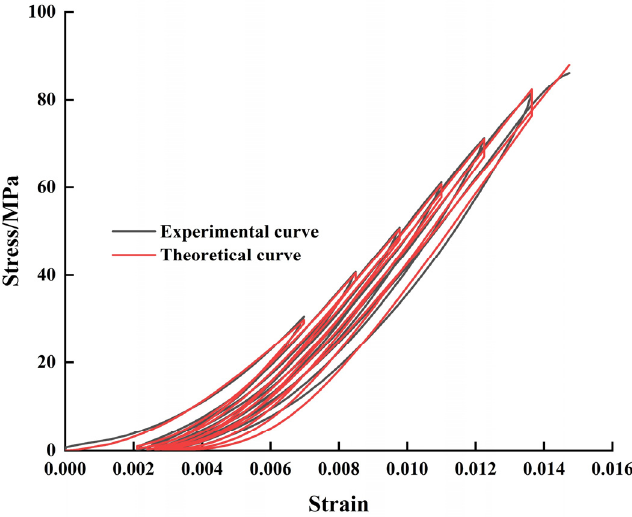
Figure 11. Experimental curve fitting of whole-stage cyclic loading process. Table 1. Fitting parameters of each